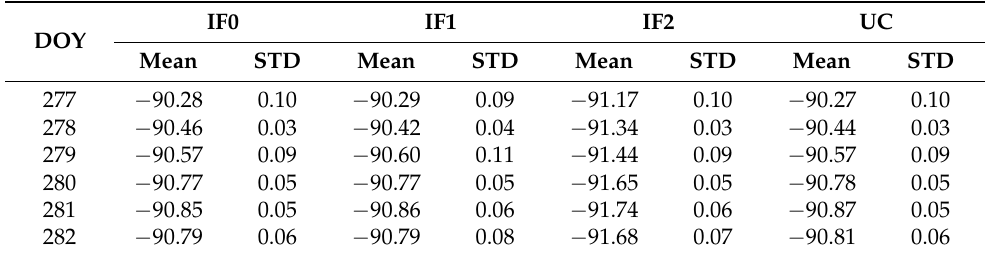
Table 6. Mean and STD values of time difference with different Galileo PPP models for PTBB-PT11 (ns).